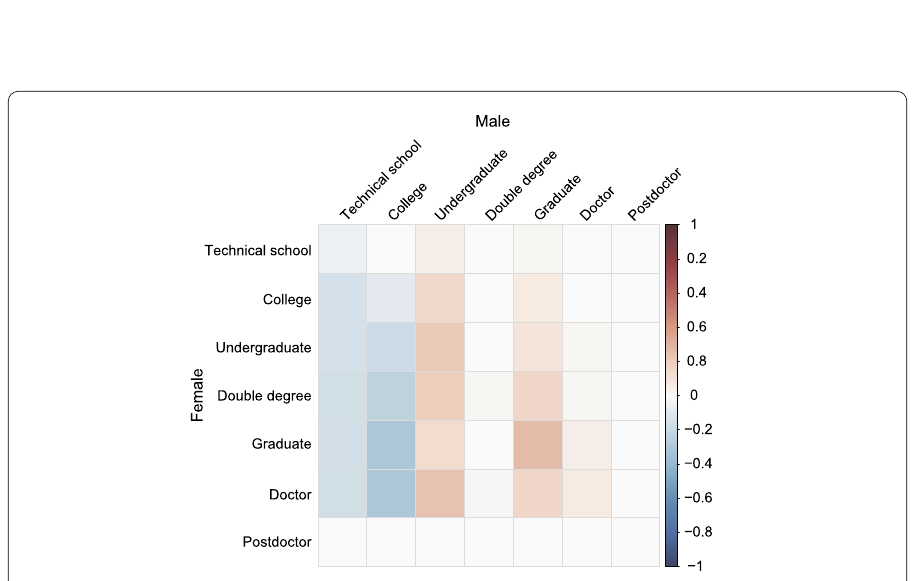
Figure 6 Education level preference for female users sending messages to male users. The vertical axis indicates the female education levels and the horizontal axis indicates the male education levels. Preference values are represented by different colors. Postdoctoral females did not send any message to men in the dataset, and we set the elements in the corresponding row to 0